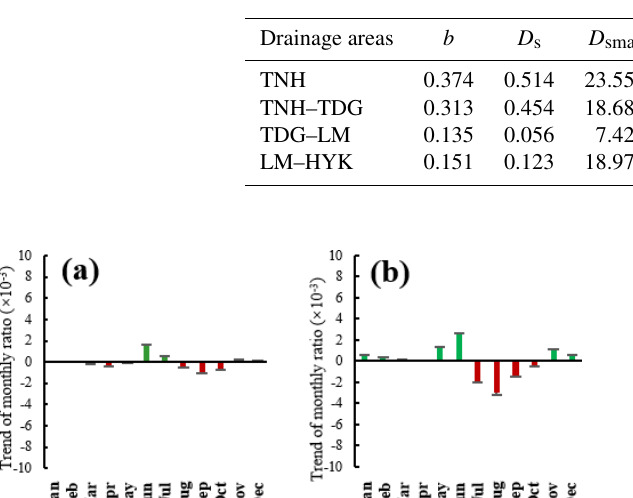
Table 3. Calibrated parameters of the VIC model for different drainage areas over the YRB.